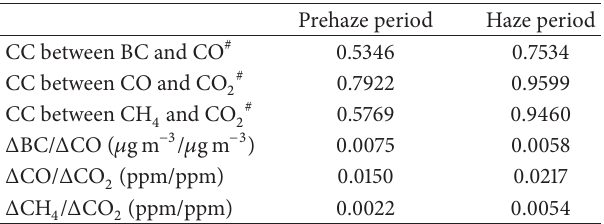
Table 1: Correlation coefficient (CC) of concentrations of BC, CO, CO 2 , and CH 4 and the ratio of Δ BC/ Δ CO, Δ CO/ Δ CO 2 , and Δ CO Δ CH 4 / 2 at Lin’an station. Prehaze